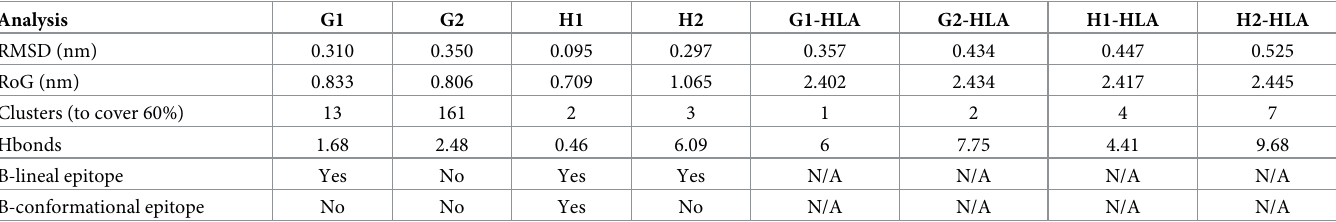
Table 3. Characteristics of the selected epitopes. Comparation of characteristics from epitopes in solution and when they are presented into HLA complex.